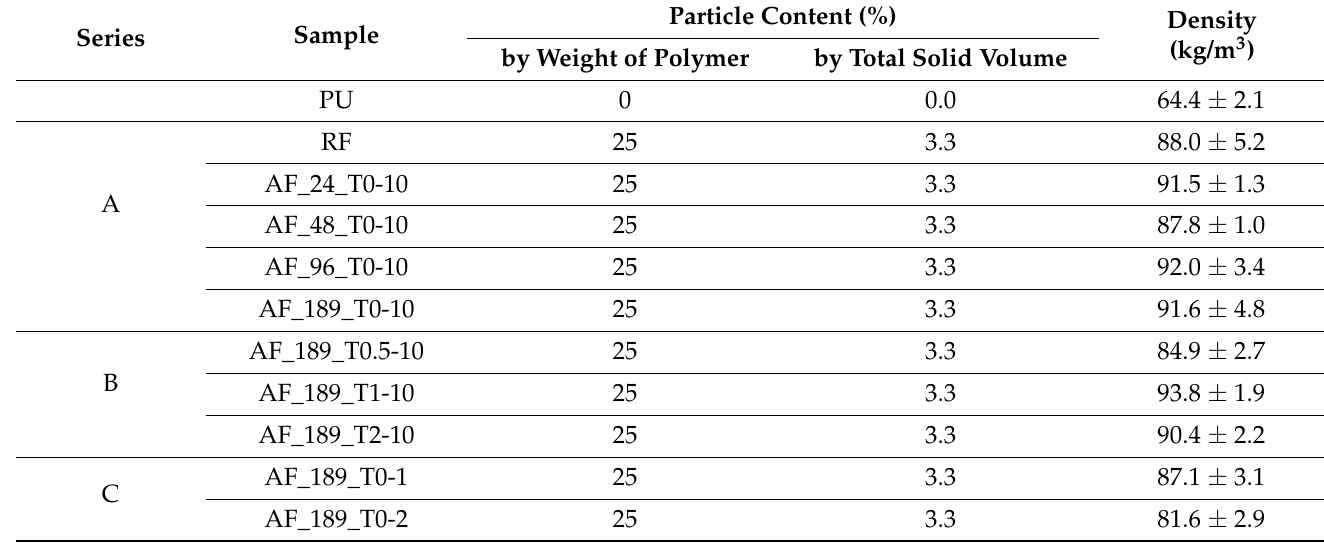
Table 1. Composition, measured density, and porosity of